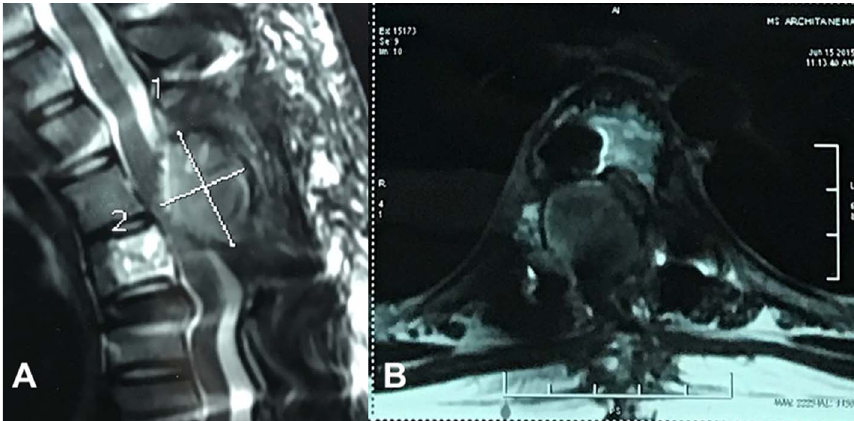
Figure 5. MRI after second recurrence showing Epidural compressive mass (cross-hairs) from the right side with underlying Myelomalacia of the spinal cord with ventral displacement on sagittal (A) and axial scans